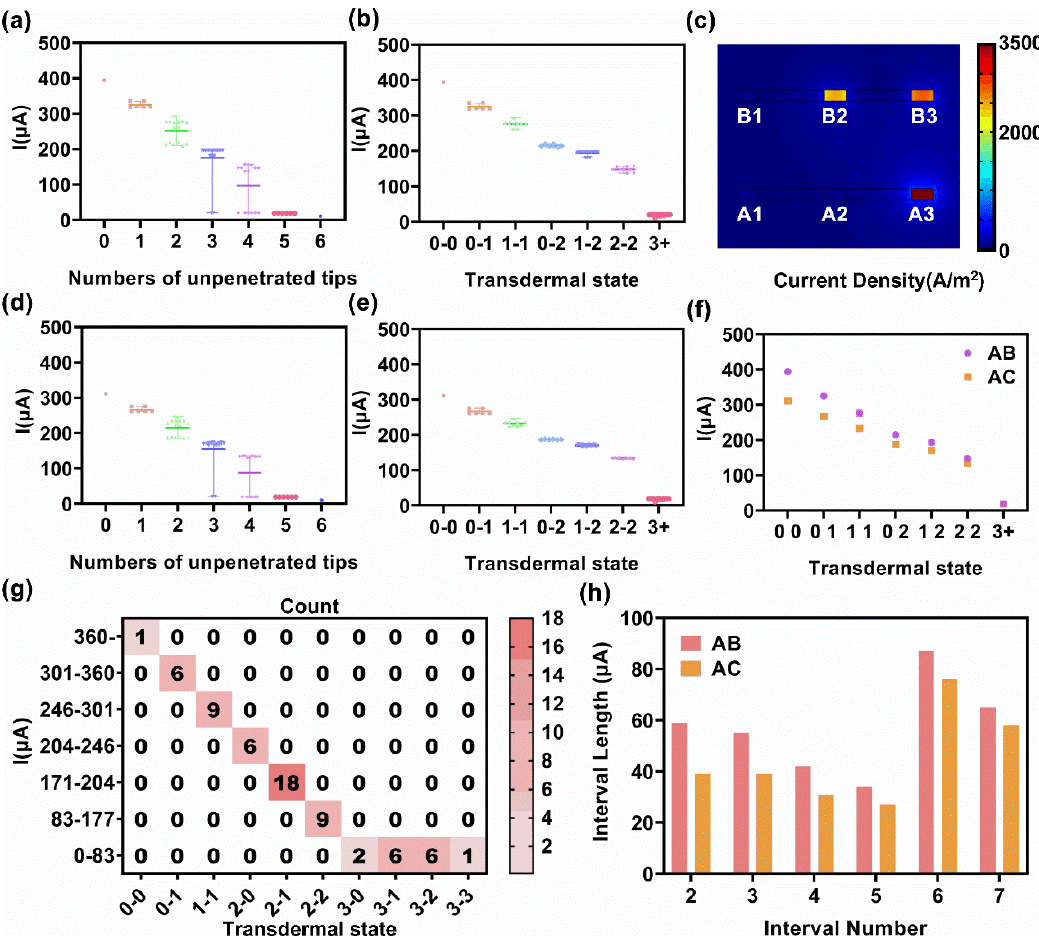
Figure 4. Simulation results of 3 × 3 microneedle array model, obtained from the statistical analysis of the terminal current after sweeping 64 transdermal events per pair of microneedle sheets. ( a ) The nested figure of the current distribution of A − B inter − sheet, divided by N total . ( b ) The nested figure of the current distribution of A − B inter-sheet, divided by the transdermal state. ( c ) A case diagram of the 2 − 1 transdermal state showing the nonuniform current contribution of the penetrated tips. The current density is represented by rainbow color. ( d ) The nested figure of the current distribution of A − C inter-sheet, divided by N total . ( e ) The nested figure of the current distribution of A − C inter-sheet, divided by the transdermal state. ( f ) The statistical results of the test current against the transdermal state. ( g ) Heat map of the current interval against the transdermal state of the A − B inter-sheet. The numerals in each cell referred to the count of transdermal events. (e.g., 18 events were enclosed into the “2−1 state”). ( h ) Histogram of the interval length of each interval. The x-axis started at interval 2 on account of that interval 1 was half open.